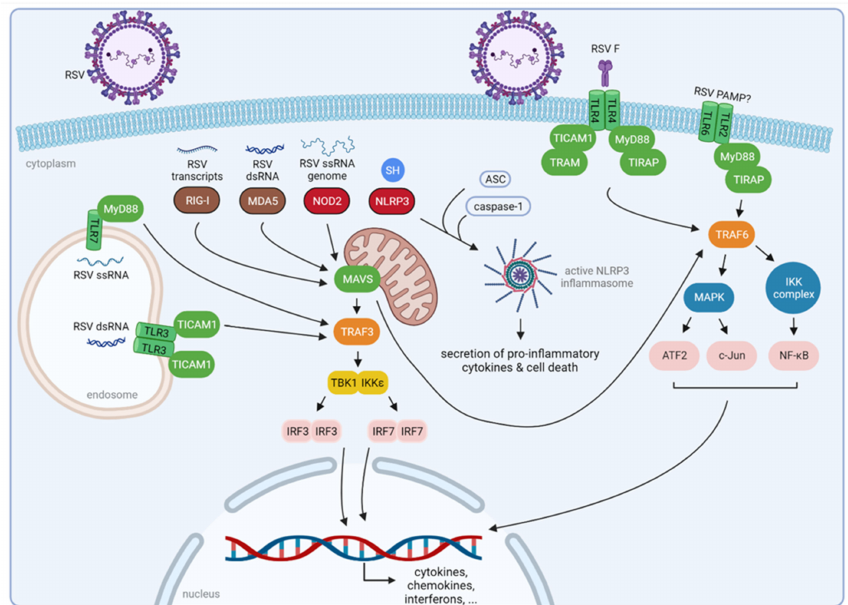
Figure 2. Innate immune recognition of RSV. Three classes of PRRs are involved in the recognition of RSV: TLRs, RLRs, and NLRs. Considering the RLRs, RIG-I binds RSV transcripts, and MDA5 is triggered by RSV dsRNA. The NLR NOD2 recognizes the RSV ssRNA genome. Activation of these RLRs and NOD2 results in downstream activation of mitochondrial-associated MAVS, which in turn induces TRAF3 and TRAF6. The TRAF3 adaptor subsequently activates the two kinases TBK1 and IKK ε , resulting in phosphorylation and activatiorn of the transcription factors IRF3 and IRF7. TRAF6 activates the MAPK and the IKK kinase complex, resulting in, respectively, phosphorylation of ATF2/c-Jun and NF- κ B. These transcription factors then translocate to the nucleus, inducing the transcription of cytokines, such as interferons, and chemokines, such as RANTES. The NLRP3 inflammasome can be activated by RSV SH. After recruitment of other host proteins, an active NLRP3 inflammasome is assembled, resulting in cell death and secretion of proinflammatory cytokines. TLRs are localized on the cell surface or intracellular components such as endosomes. The mechanism of RSV virion recognition by TLR2/6 remains unknown, whereas TLR3 and TLR7 recognize an RSV dsRNA intermediate and ssRNA, respectively. TLR4 is suggested to be activated by RSV F. Activation of TLRs results in the recruitment of adaptor proteins necessary for downstream signaling. TLR2 recruits MyD88 and TIRAP, as does TLR4. In addition, TLR4 can recruit TICAM1 and TRAM. MyD88 is used by TLR7 as an adaptor protein, whereas TLR3 signals through TICAM1. The adaptor proteins converge at TRAF3 or TRAF6 which become activated, ultimately resulting in an antiviral response through downstream signaling. ASC, apoptosis-associated speck-like protein containing a caspase recruitment domain; ATF2, activating transcription factor 2; IKK, inhibitor of nuclear factor kappa-B kinase; IRF3, interferon regulatory factor 3; IRF7, interferon regulatory factor 7; MAPK, mitogen-activated protein kinase; MAVS, mitochondrial antiviral-signaling protein; MDA5, melanoma differentiation-associated protein 5; MyD88, myeloid differentiation primary response protein MyD88; NF- κ B, nuclear factor-kappa B; NLR, nucleotide-binding oligomerization domain (NOD)-like receptors; NLRP3, NOD-like receptor family, pryin domain containing; NOD2, nucleotide- binding oligomerization domain-containing protein 2; PAMP, pathogen-associated molecular pattern; PRR, pattern recognition receptor; RIG-I, retinoic-acid-inducible gene-I; RLR, RIG-I-like receptor; RSV, respiratory syncytial virus; TBK1, tank binding kinase 1; TICAM1, toll/interleukin-1 receptor domain-containing adapter molecule 1; TIRAP, toll/interleukin-1 receptor domain-containing adapter protein; TLR, toll-like receptor; TRAF3, tumor necrosis factor receptor-associated factor 3; TRAF6, tumor necrosis factor receptor-associated factor 6; and TRAM, toll-like receptor adaptor molecule. Figure created with BioRender software (BioRender.com (accessed on 13 January